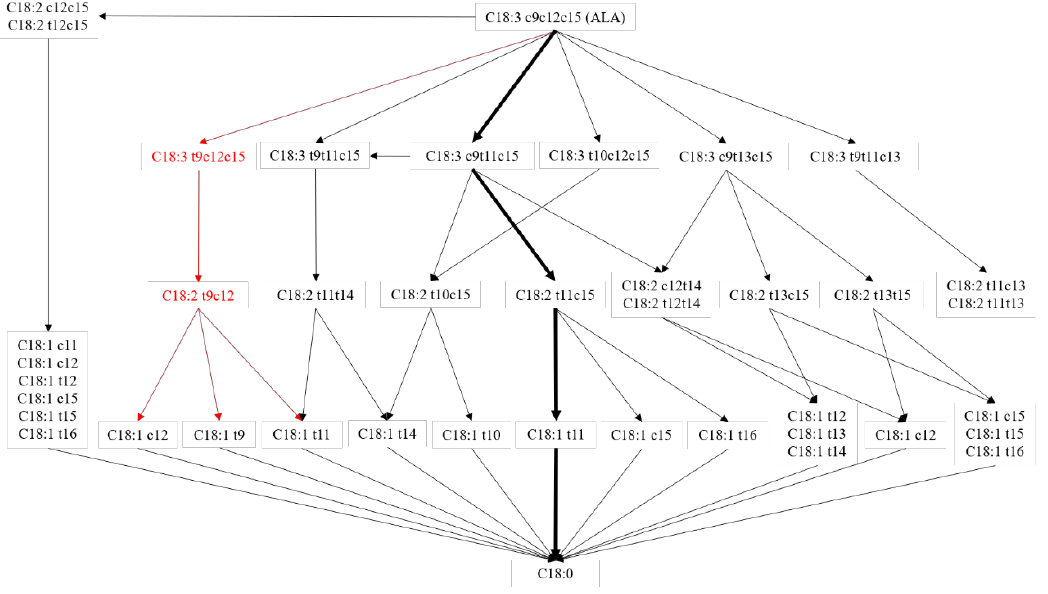
Figure 3. ALA biohydrogenation pathways in the rumen. Adapt from [4]. Red line pathway: reported in this experiment; black line pathway: reported by previous study; black bold line pathway: main biohydrogenation pathways in the rumen.